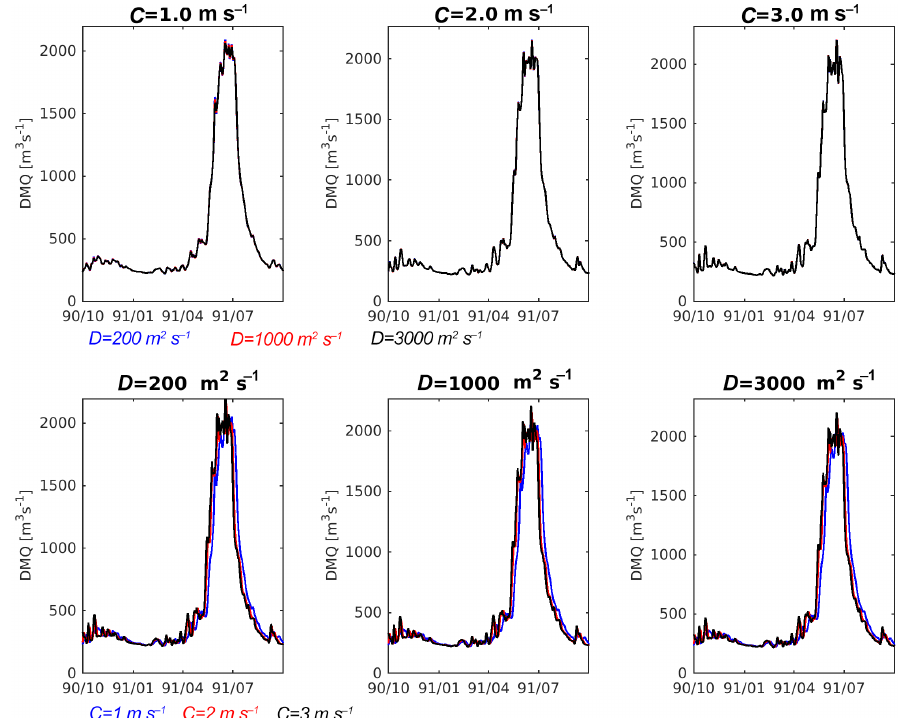
Figure 9. Sensitivity of simulated runoff at Colorado River at Lees Ferry (location B in Fig. 5) to IRF-UH parameters. The top panels show sensitivity to diffusivity D with three fixed celerity C values (from left to right: C = 1.0, 2.0, and 3.0ms − 1 ) . The bottom panels show sensitivity to celerity C with three fixed diffusivity D values (from left to right: D = 200, 1000, and 3000ms − 2 )